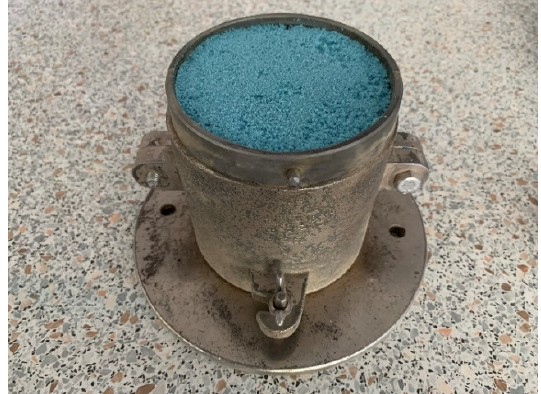
Figure 8. Steel cylindrical container with kinetic sand sample before compaction.